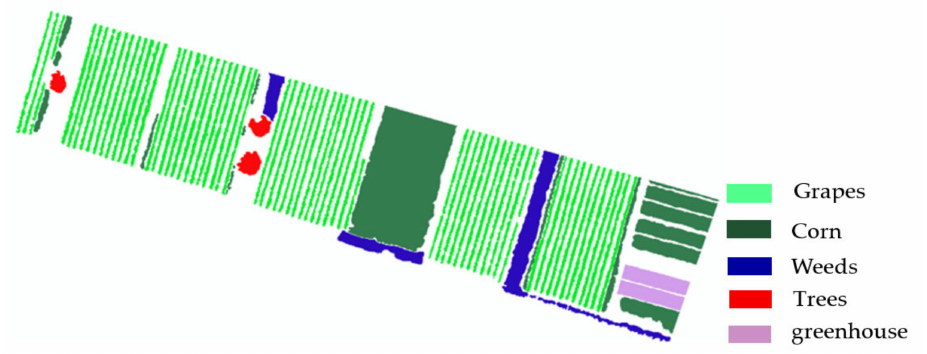
Figure 10. Interpretation of the test set